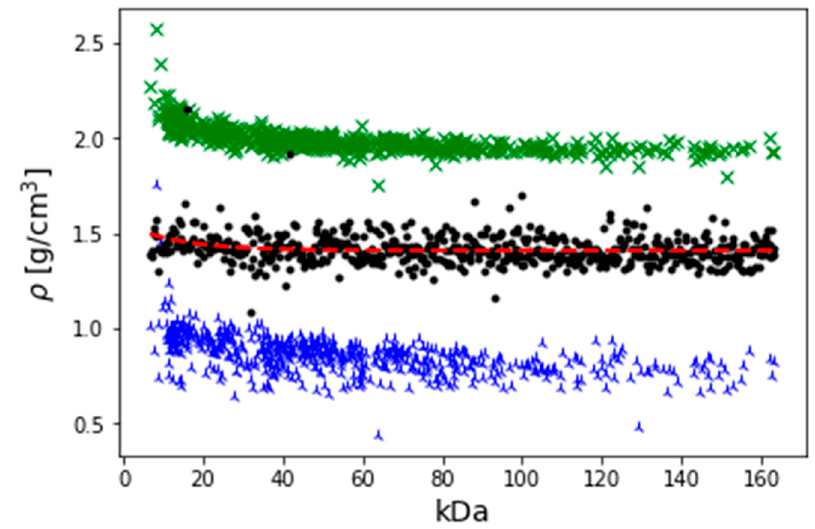
Figure A3. A distribution of density versus mass for a range of proteins of various sizes. Blue: van der Waals radius. Green: Etch radius Red: Experimentally desired result Black: Optimised linear combination of van der Waals radius and etch radius.